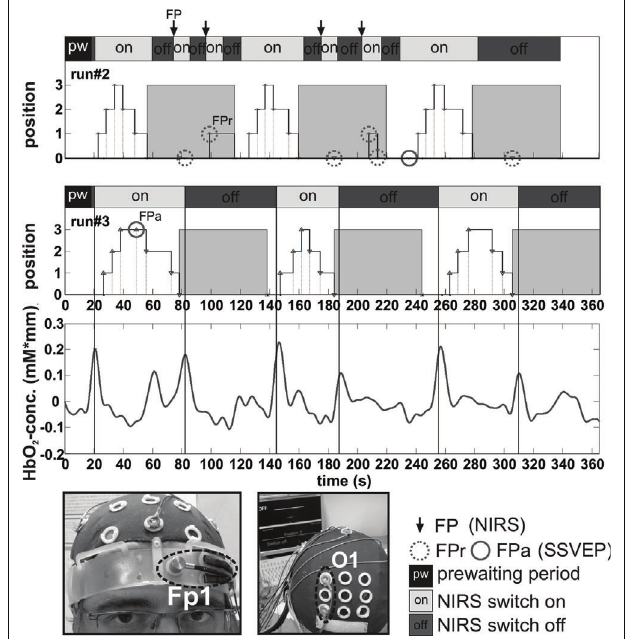
FIGURE4 | From top to bottom: Position trace of the switch (grey areas mark closed switch position) and four-step SSVEP-based orthosis control trace (grey areas indicate 60-s resting periods) of run#2; position trace of brain switch and orthosis control of run#3; level of oxyhemoglobin (HbO ) concentration of run#3; views of prefrontal optodes and bipolar 2 occipital EEG electrode placements. FPs of switch (FP) and SSVEP-based orthosis control (FPa, FPr) are indicated. Note the HbO the intended mental tasks.